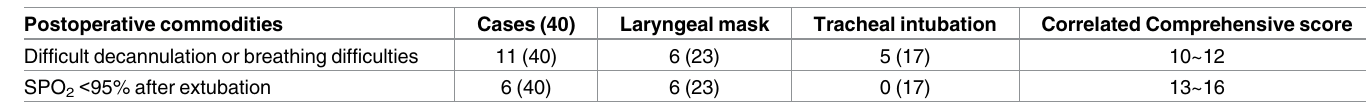
Table 4. Postoperative airway commodities in 40 PRS